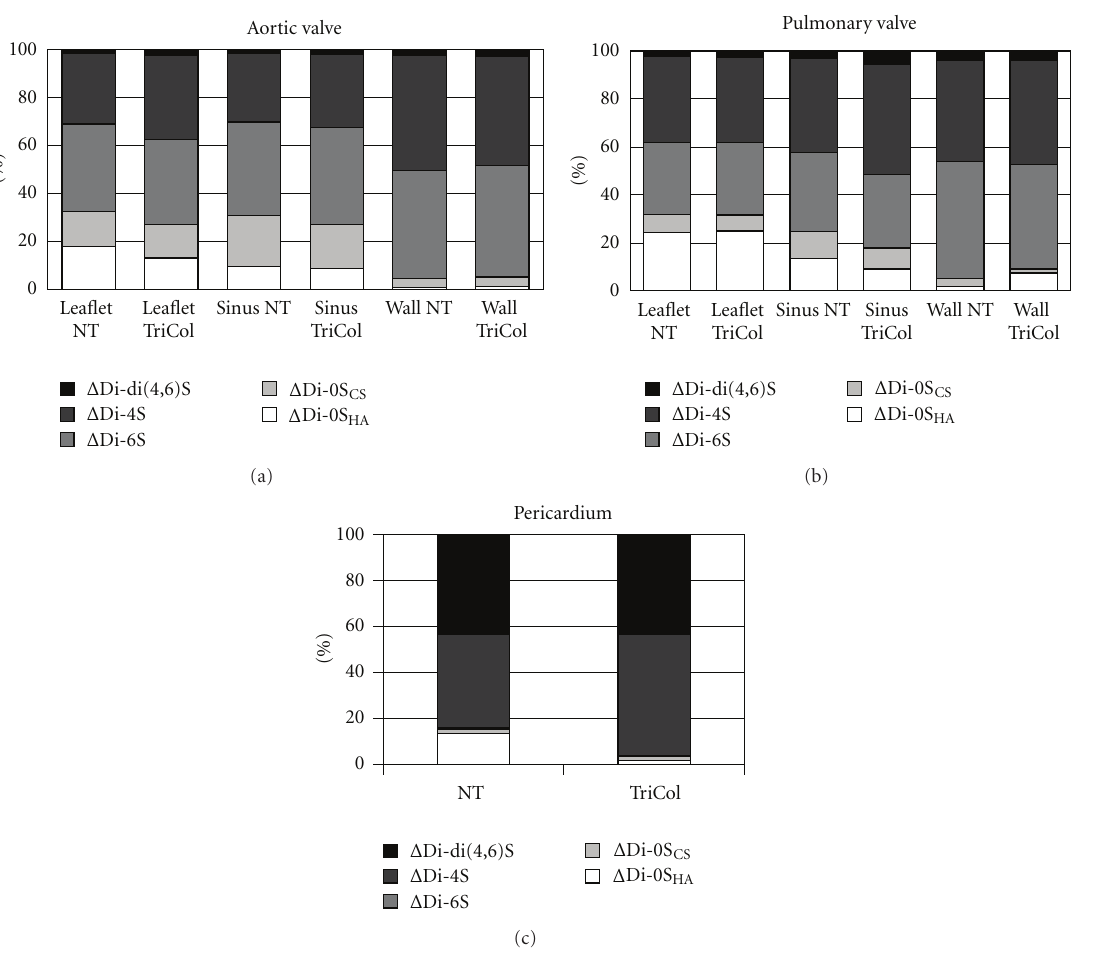
Figure 2: Relative Δ -disaccharides content in fresh (NT) and decellularized (TriCol) porcine heart valves and pericardium, as calculated from FACE